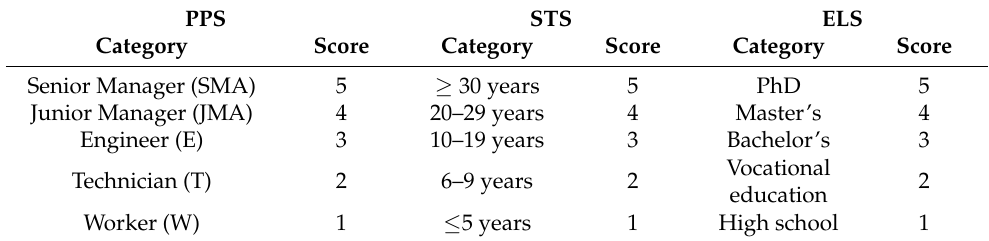
Table 4. The weighting criteria of